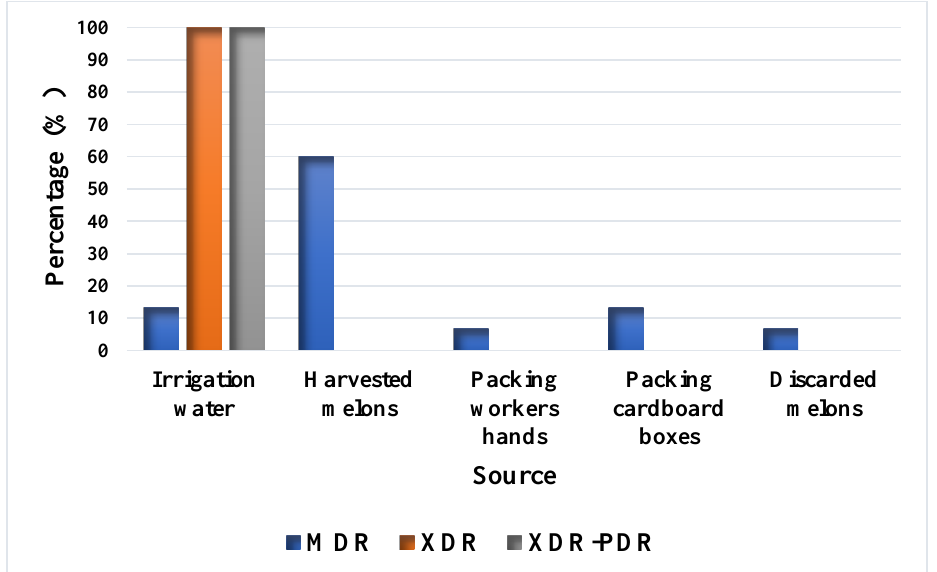
Figure 3. Percentages of E. coli strains with specific antibiotic resistance isolated from different points of the Honeydew melon farm and packing facility in Hermosillo, Sonora. MDR: multi-drug-resistant; XDR: extremely resistant; XDR-PDR: extremely resistant with a tendency to be pandrug-resistant.